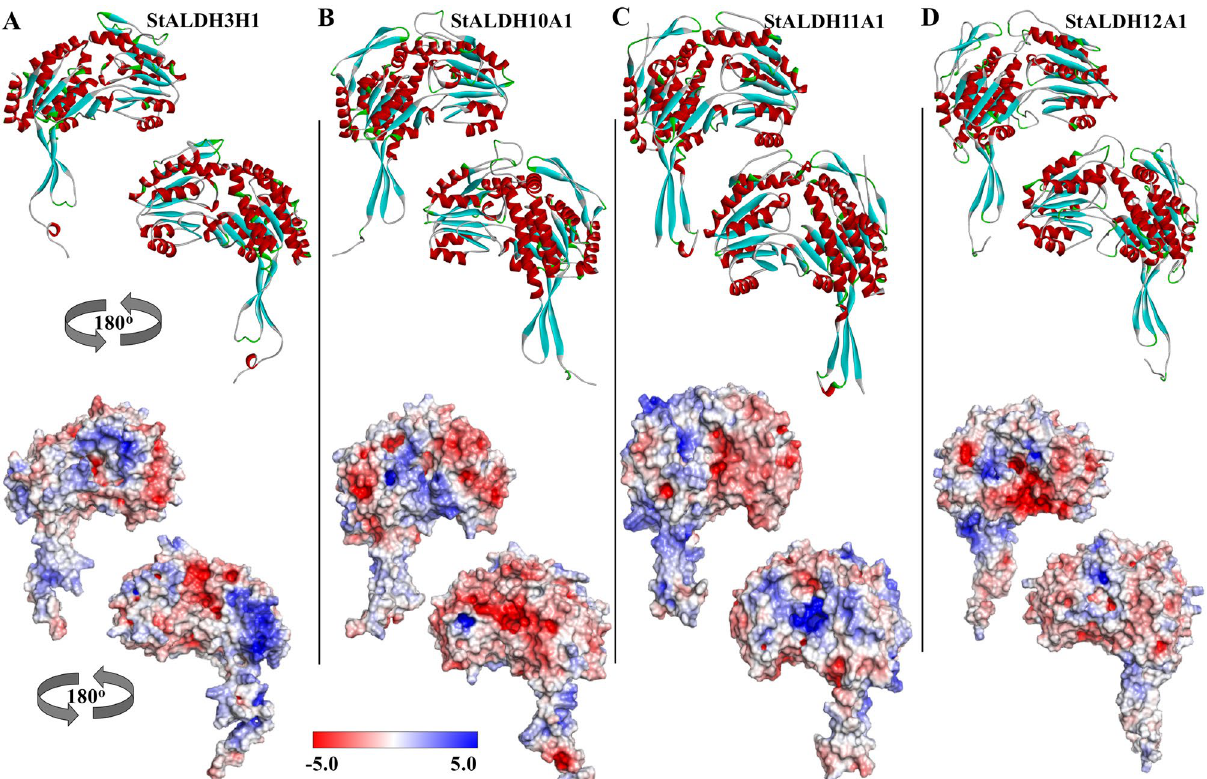
Figure 8. Three-dimensional structure analysis of the selected StALDH proteins. Four highly abiotic stress- specific upregulated proteins ( A ) StALDH3H1, ( B ) StALDH10A1, ( C ) StALDH11A1, and ( D ) StALDH12A1 were selected for homology modelling. All the structures were depicted as cartoon diagram for the structure analysis of each protein in two different views (rotated 180°). The electrostatic surface potential of each selected proteins was illustrated to show charge distribution in the surface of the proteins. The surface colours were clamped at red (− 5) and blue (+ 5). Red and blue colour indicated negatively and positively charged amino acids, respectively. All the structures were visualized and generated using Discovery Studio Visualizer 2016 software (https:// disco ver. 3ds. com/ disco very- studio- visua lizer- downl